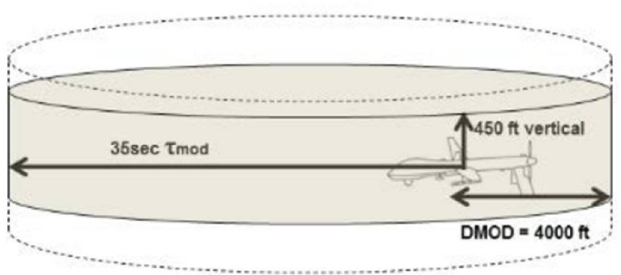
Figure 1. RTCA DO-365 Well Clear volume definition [16].